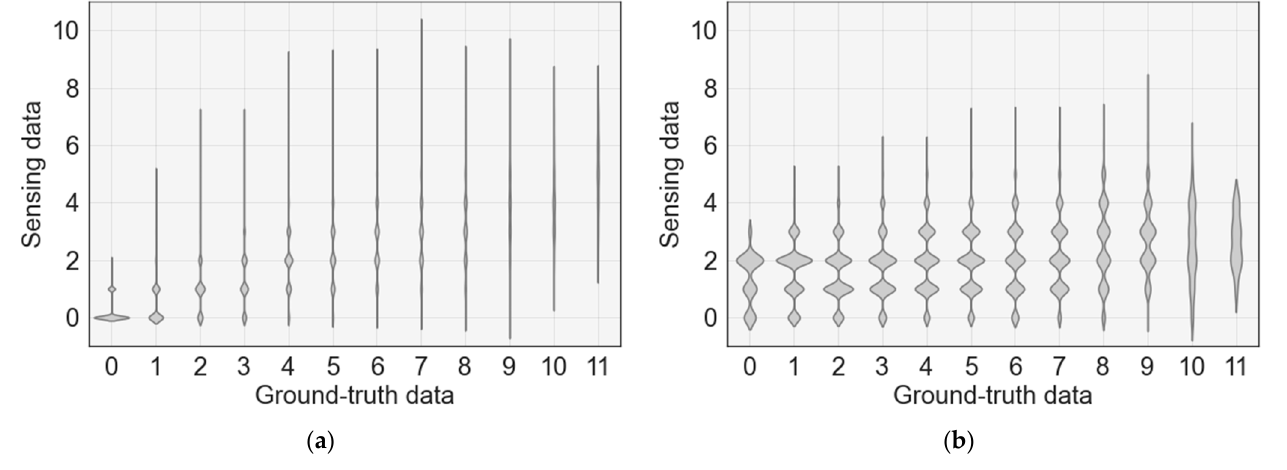
Figure 8. Analysis of occupancy count error distribution between sensing and ground-truth data: